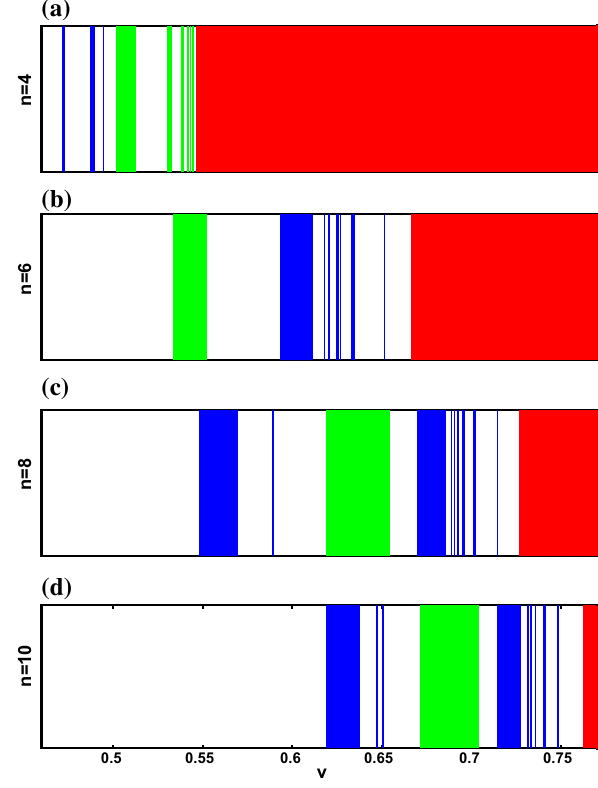
Fig. 17 Antikink-kink collisions and two pulses formation for n = 6 with v = 0 . 6267 Fig. 18 Antikink-kink collisions: bion (white), two propagating oscil- lations(blue),two-bouncewindows(green)andinelasticscatteringwith one-bounce (red) for a n = 4, b n = 6, c n = 8, and d n = 10